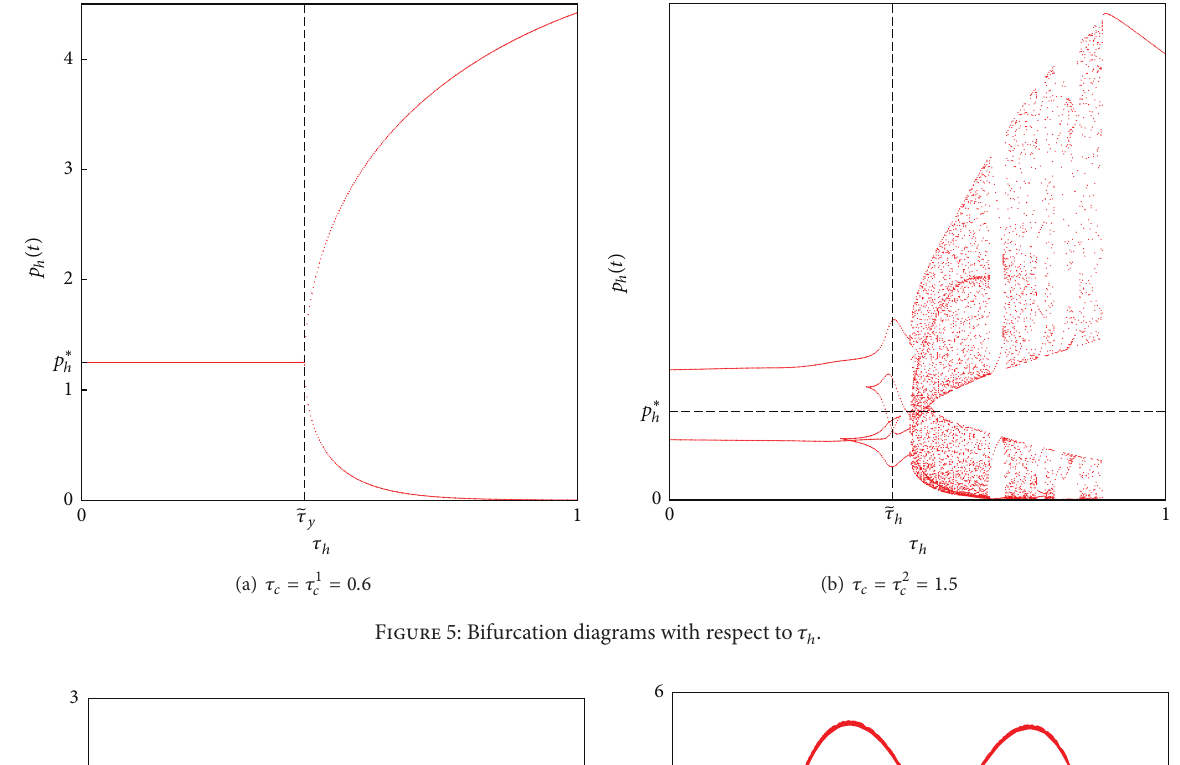
Figure 5: Bifurcation diagrams with respect to 𝜏 ℎ .